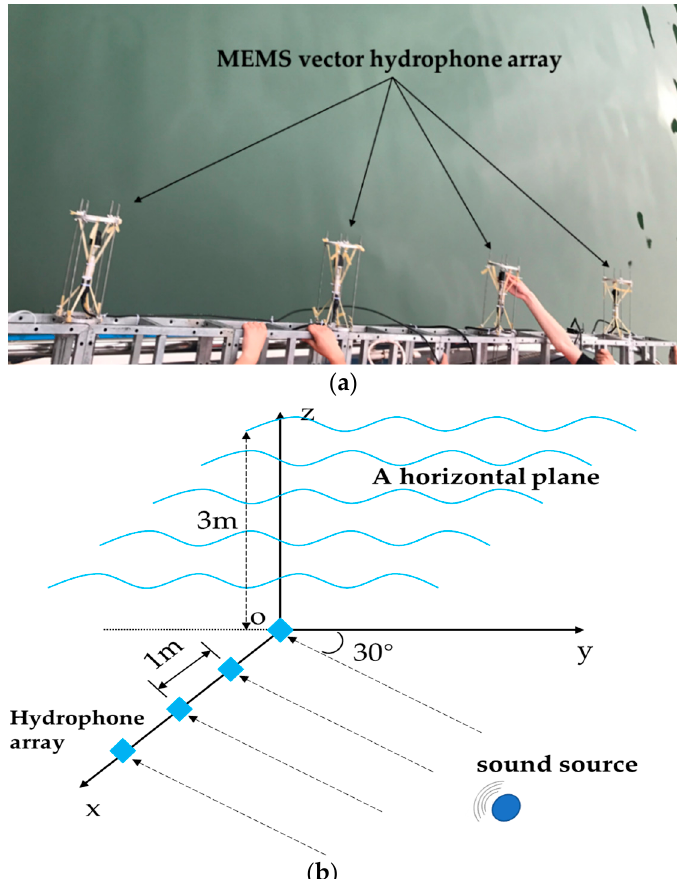
First of all, because of the signals are collected by a four-element horizontal uniform linear array, multiple signals were generated. In this experiment, use the average value of the power spectrum entropy of the multiple signals to characterize the noise complexity of the signal source, and then the appropriate regularization parameters are selected. In this experiment, the regularization parameter is 12 and the number of snapshots is 30.